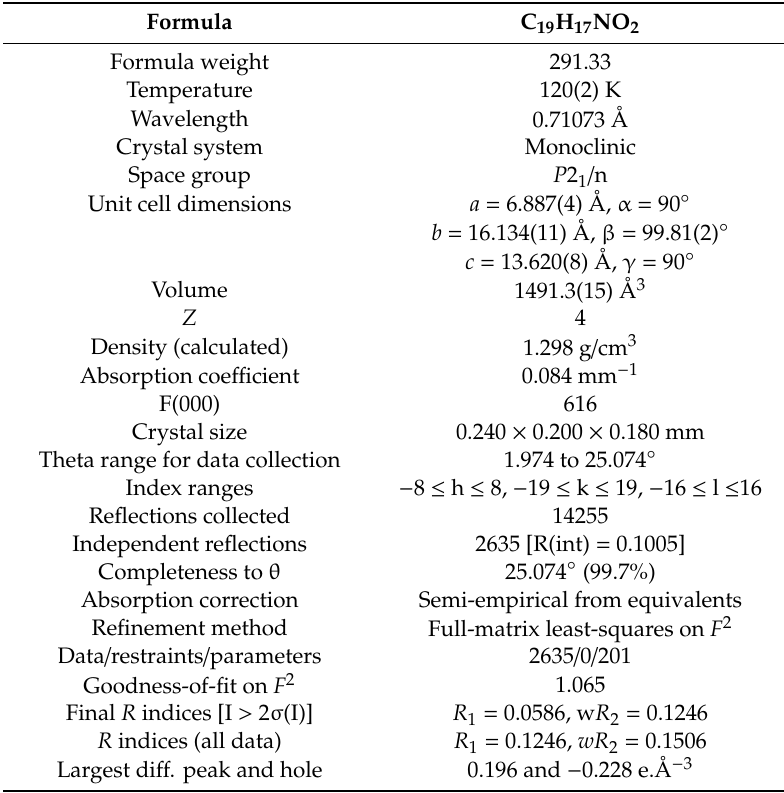
Table 2. Crystal data and structure refinement for 11